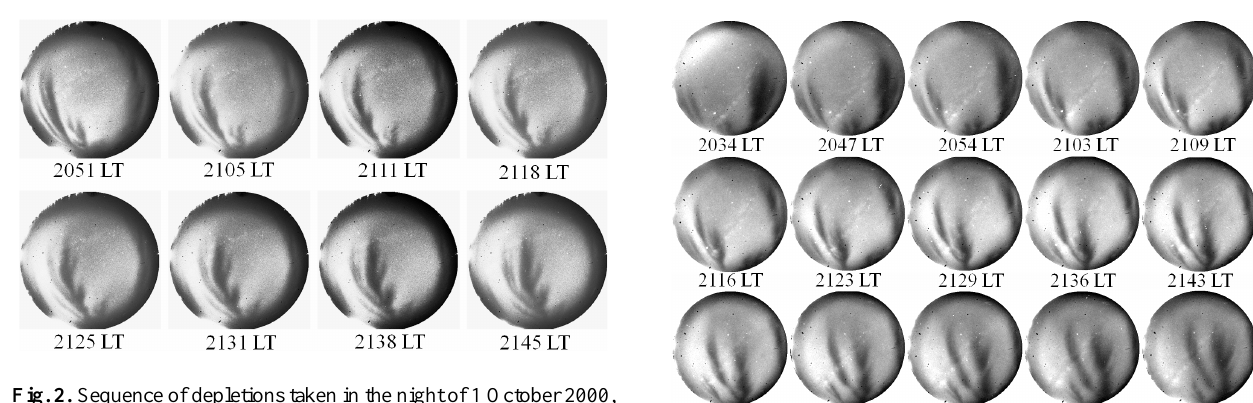
Fig. 2. Sequence of depletions taken in the night of 1 October 2000, from Mt. Alishan, showing overhead bifurcation. The orientation of the images is same as that in Fig. 1.